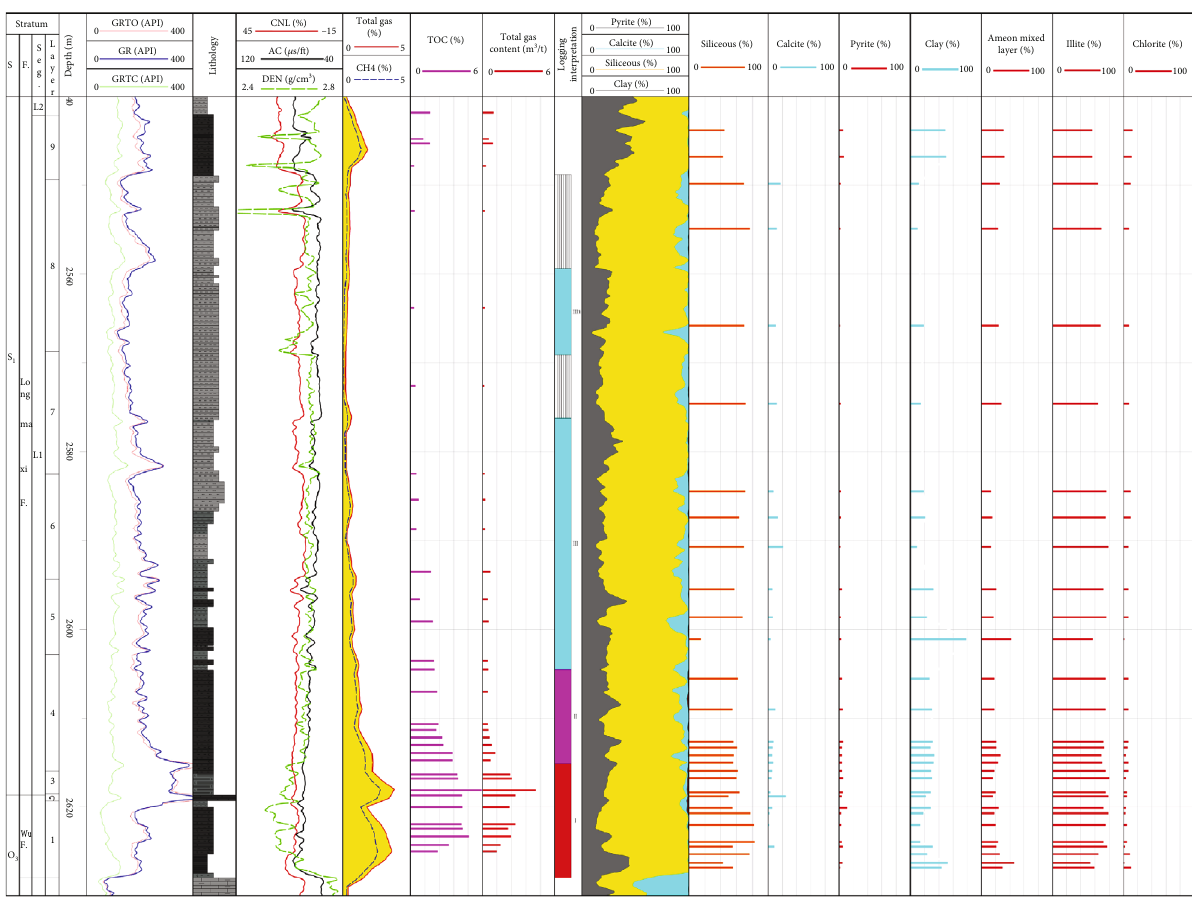
Figure 3: Comprehensive analysis of mineral composition of well ZY1 in Wufeng-Longmaxi Formation in Qianjiang area, southeast